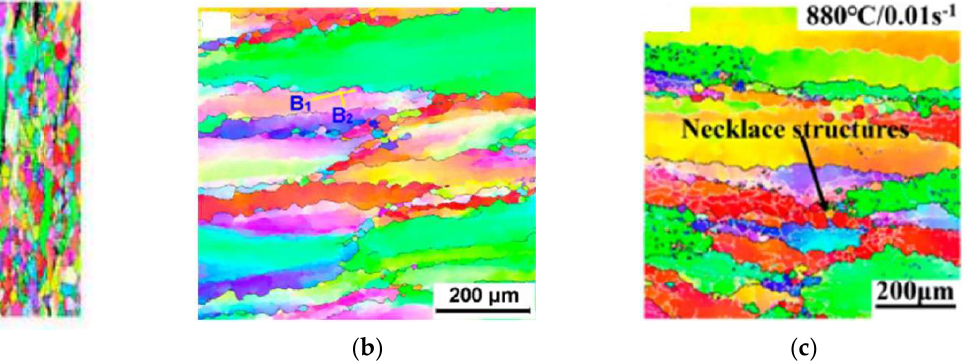
Figure 2. Examples of microstructures exhibiting DRX in various alloys: ( a ) DDRX in a highly alloyed austenitic stainless steel (1000 °C, 10 − 4 s − 1 , ε = 1) [8]; ( b ) onset of CDRX/DDRX in a Zr-Ti-Al-V alloy (800 °C, 10 − 2 s − 1 , ε = 0.7) [9]; ( c ) onset of CDRX in Ti-35421 (880 °C, 10 − 2 s − 1 , ε = 0.9) [10].